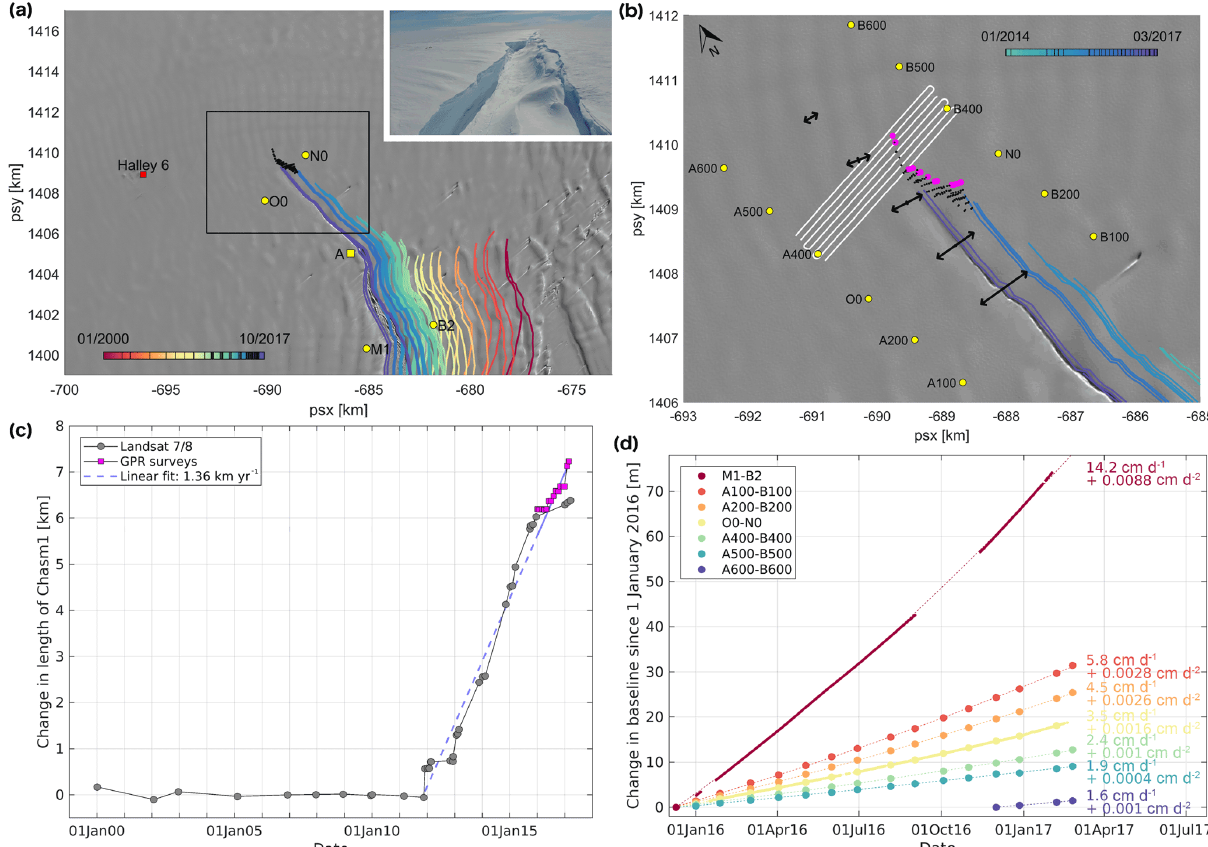
Figure 2. (a) Historical outlines of Chasm 1 from 6 January 2000 (red) to 15 March 2017 (purple), as the rift got advected by the ice flow. Outlines were obtained from a sequence of Landsat 7 and Landsat 8 panchromatic images, with acquisition dates as indicated by the black ticks in the colour bar. The background image is a subset of a Landsat 8 scene from 15 March 2017. The red dot indicates the location of Halley 6 research station, yellow dots are the locations of four permanent dual-frequency GPS stations, and the black box outlines the extent of (b) . The inset in the top right shows an aerial image of Chasm 1 taken in December 2015, looking from the reference point A towards the crack tip. (b) Detailed overview of the area around the tip of Chasm 1, showing the local snow stake network (yellow dots), an example of the GPR survey lines (white lines), and progression of the crack tip as obtained from satellite (blue-to-purple outlines) and GPR data (black dots). Strain rosettes were obtained from the relative movement of the snow stakes; they capture the widening of Chasm 1 as well as local strain rates in the ice shelf. (c) Propagation of the tip of Chasm 1 with respect to its historical location prior to the reactivation in December 2012, based on Landsat 7/8 images (grey markers) and monthly GPR surveys (magenta markers). A linear fit through all data points shows an average lengthening rate of the rift of 1.36kmyr − 1 . (d) Baseline distance across Chasm 1 as a function of time, measured by two pairs of permanent GPS stations ( O 0– N 0 and M 1– B 2 in a ) and five pairs of snow stakes ( A i – B i , with i ∈ { 100 , 200 , 400 , 500 , 600 } in b ). The least-squares quadratic fit is plotted as a dashed